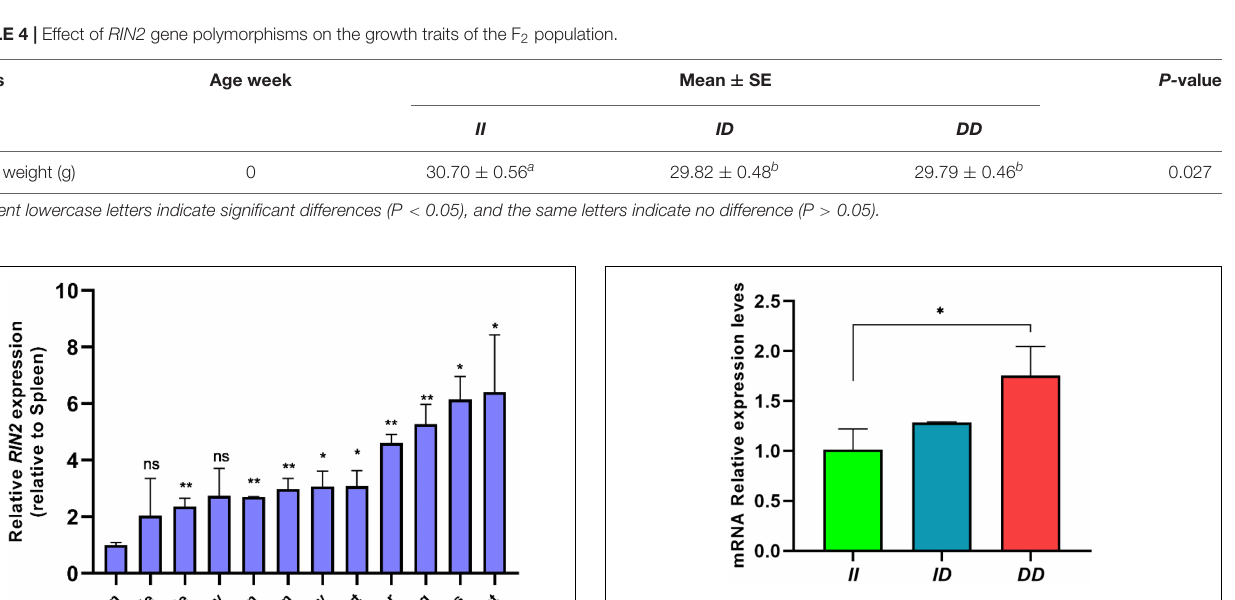
FIGURE 6 | Expression of RIN2 mRNA in abdomen fat tissue of individuals with different genotypes. Data are presented as the means ± SD ( n = 3 repetitions for each group). * P < 0.05, significant difference.